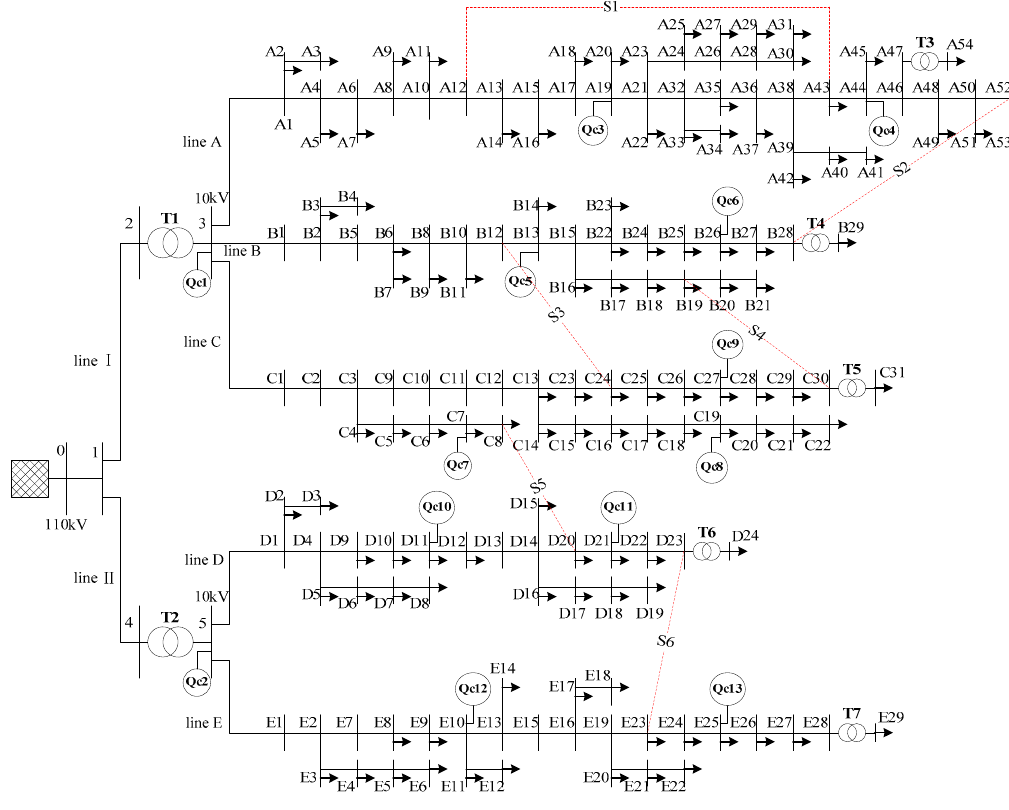
Figure 5. Connection diagram of a practical distribution network with 173 nodes.